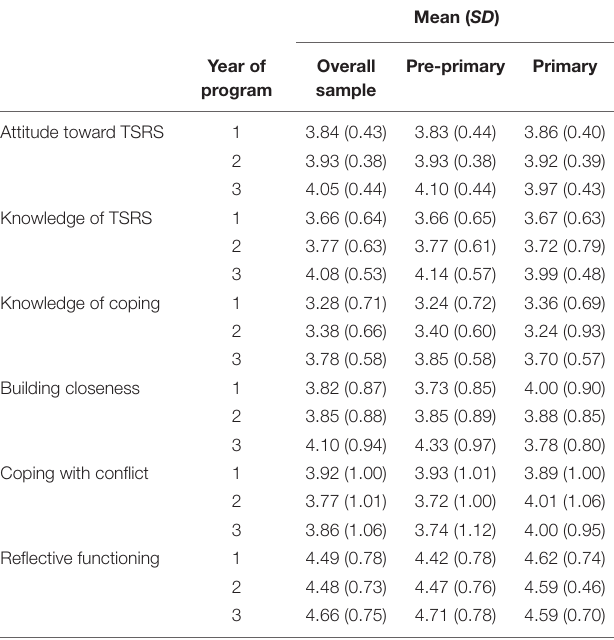
TABLE 12 | Descriptive statistics for each year of teacher training.